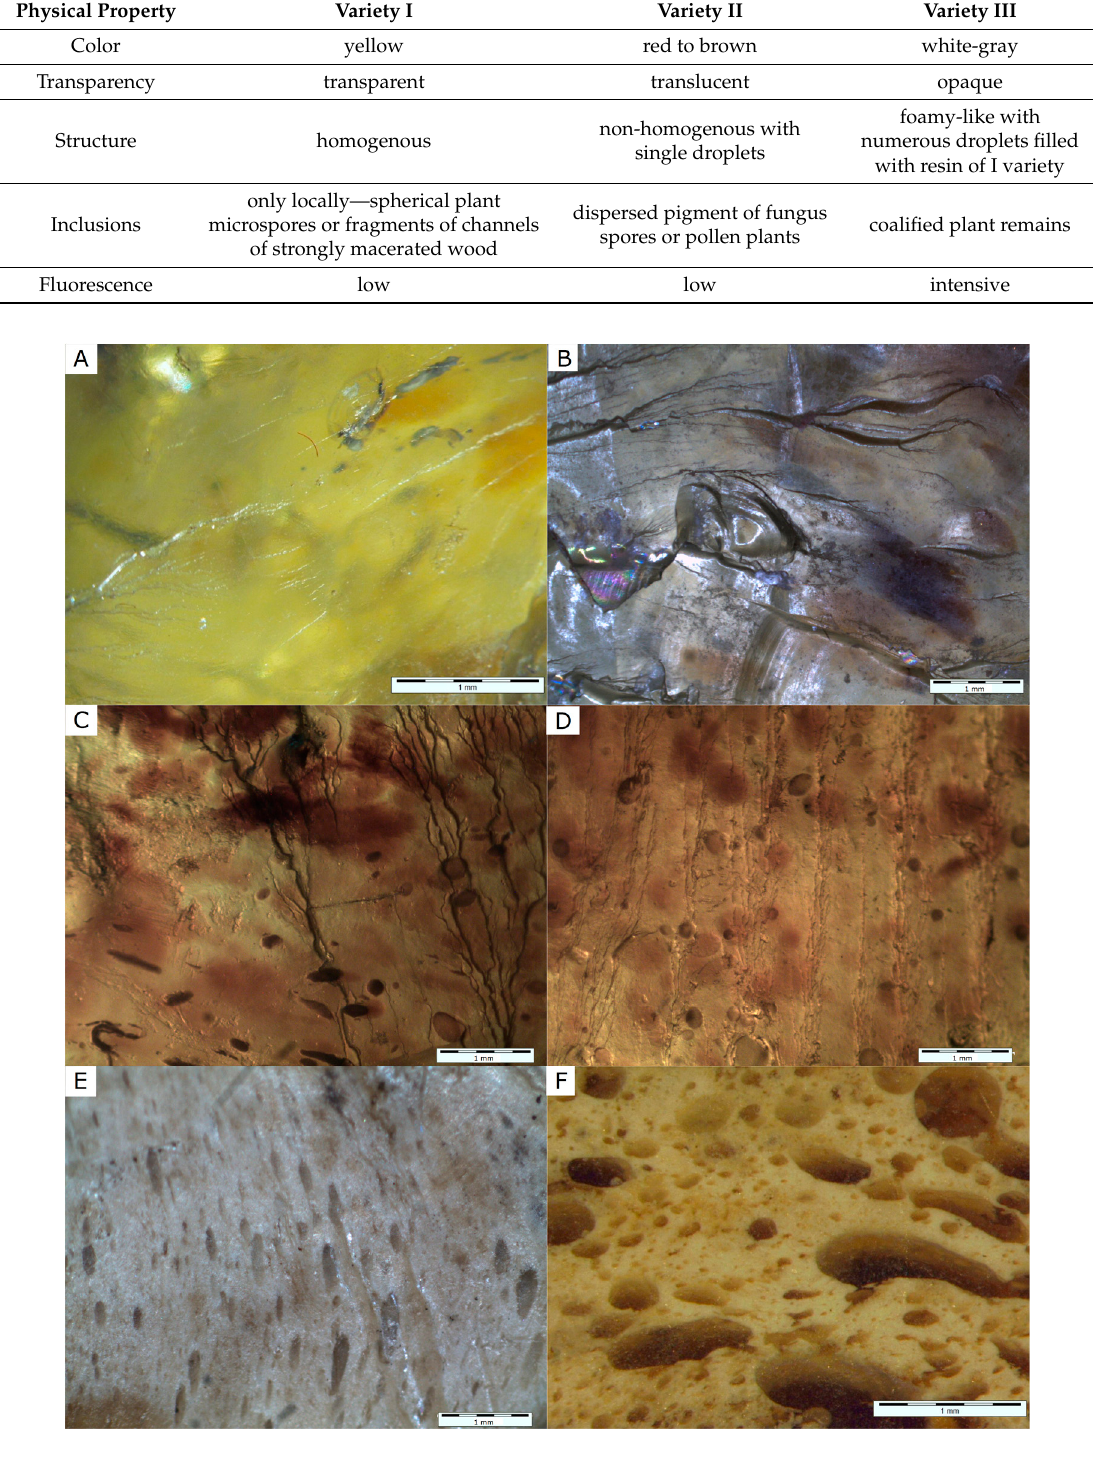
Table 1. Macro- and microscopic characteristics of Sumatran fossil resins.